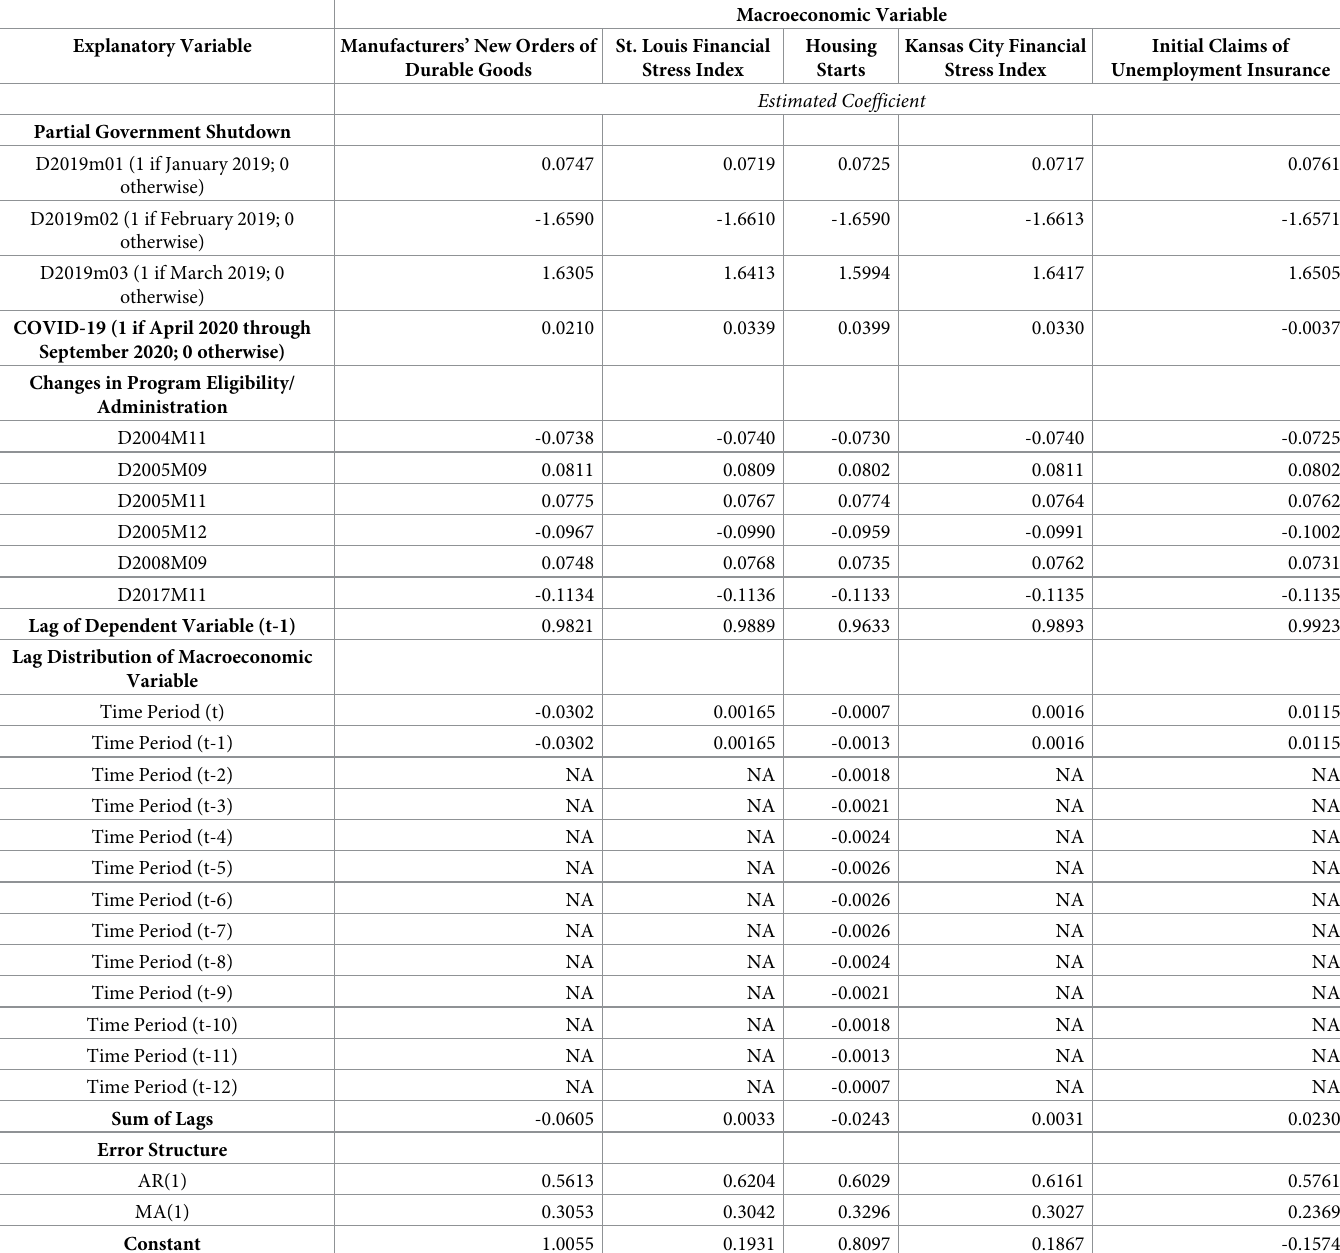
Table 1. Estimated econometric models associated with SNAP participation, October 1999 to September